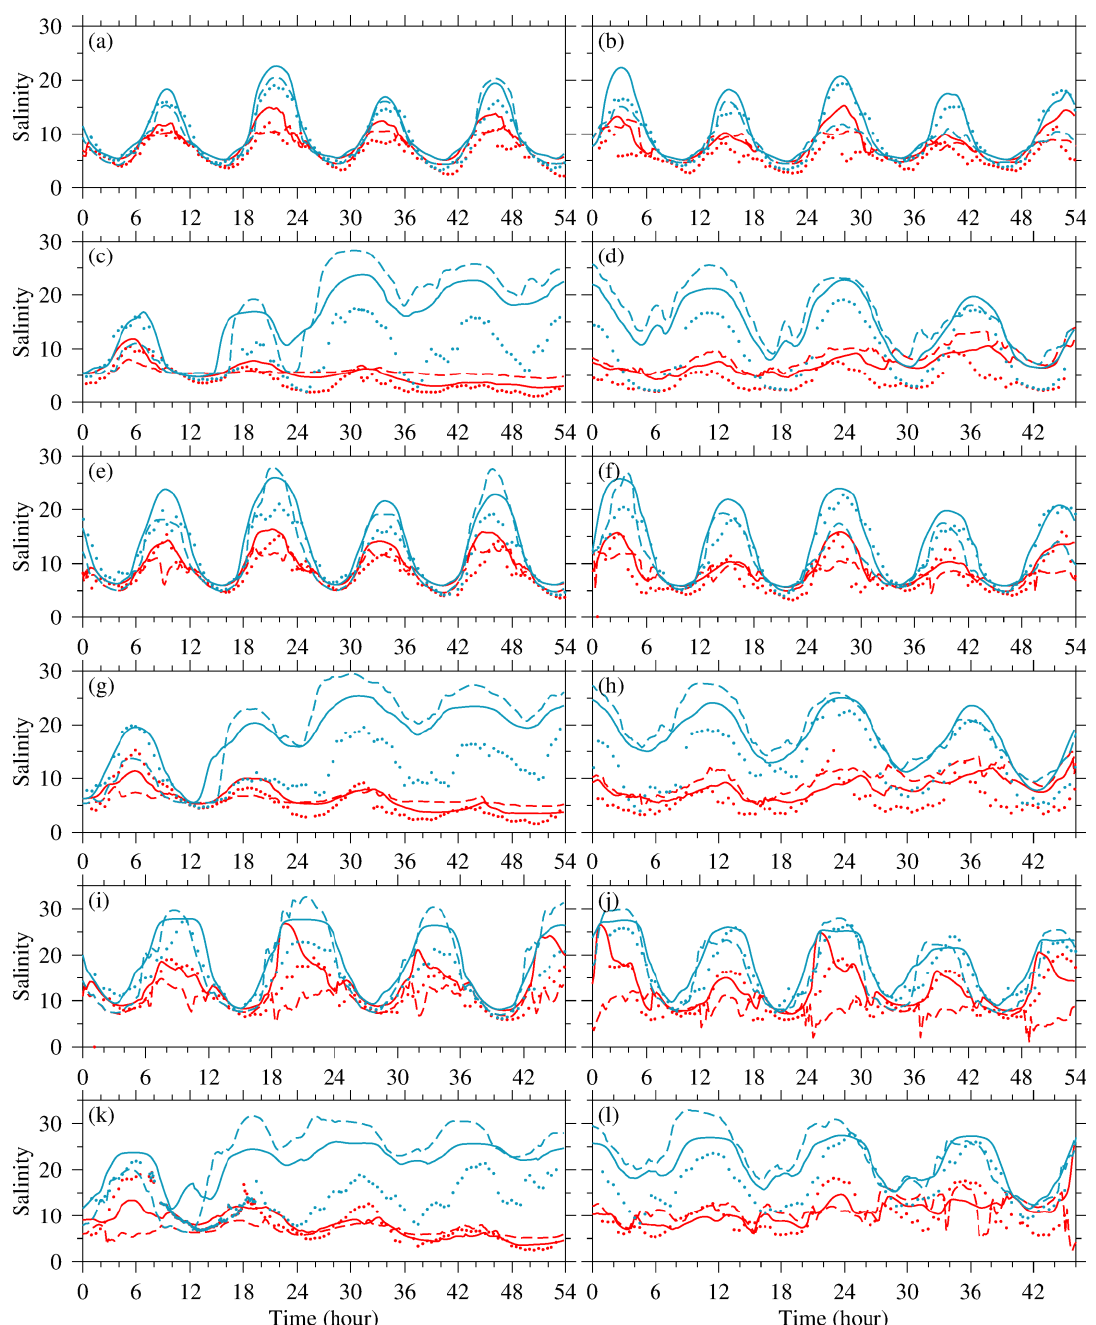
Figure 12. Time series of salinity obtained from the observed data (dots), Exp. 0 (solid lines) and Exp. 3(dashed lines) at sites A ( a – d ), B ( e – h ), and C ( i – l ) during four tidal phases (spring: a , e , i ; MTAS: b , f , j ; neap: c , g , k ; MTAN: d , h , l ). Red indicates surface and blue indicates bottom.